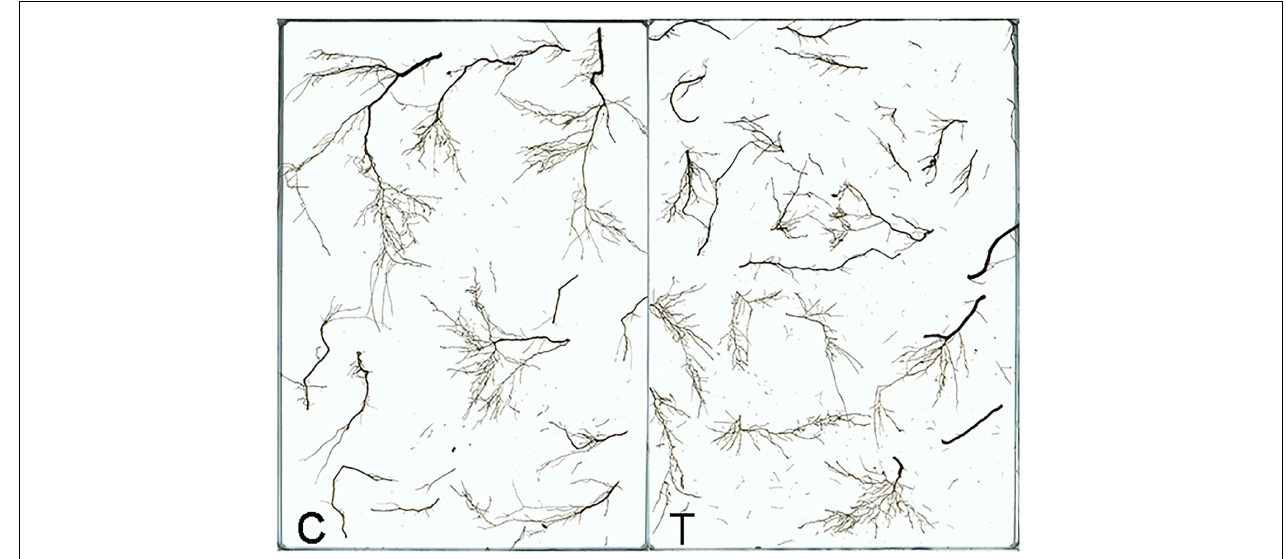
FIGURE 2 | The root system of tea plant seedlings as affected by AMF. C: non-mycorrhizal treatment, T: mycorrhizal treatment. TABLE 1 | Results of plant biomass and relevant indexes of root system architecture induced by AMF inoculation. Treatment Mycorrhizal colonization and plant biomass